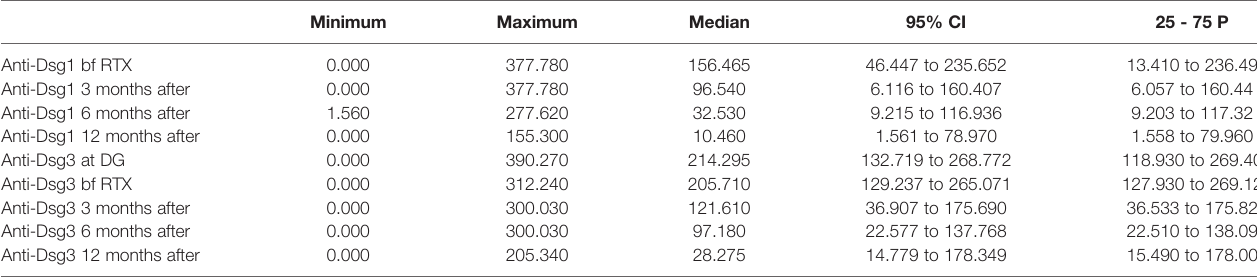
TABLE 3 | Descriptive statistics for anti-Dsg 1 and anti-Dsg 3.